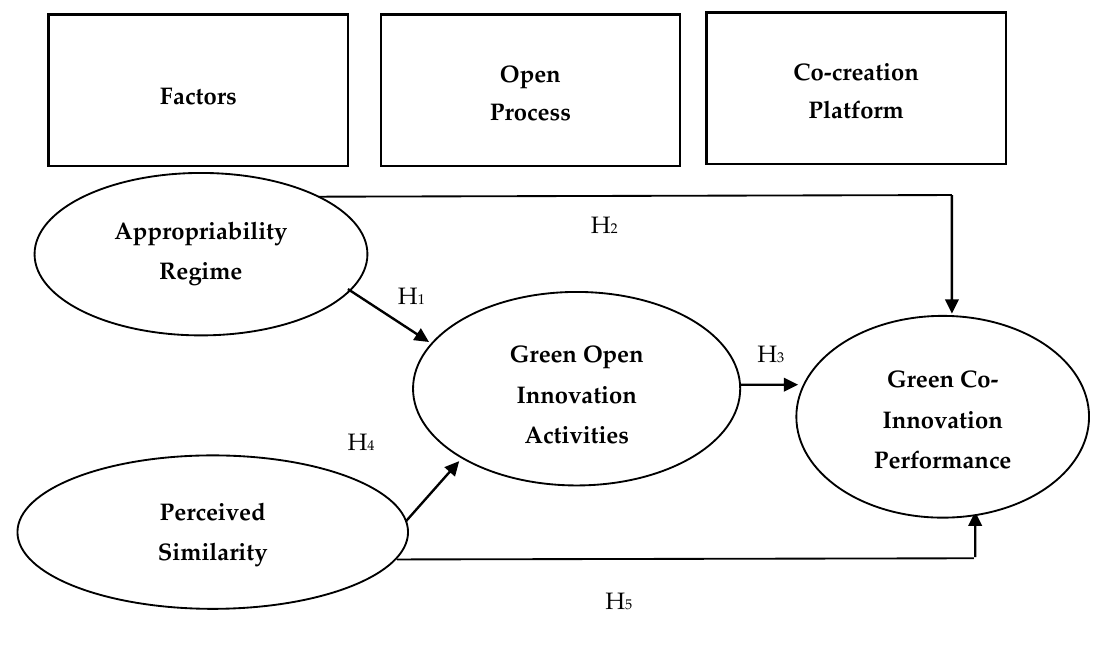
Figure 1. Research Figure 1. Research framework.